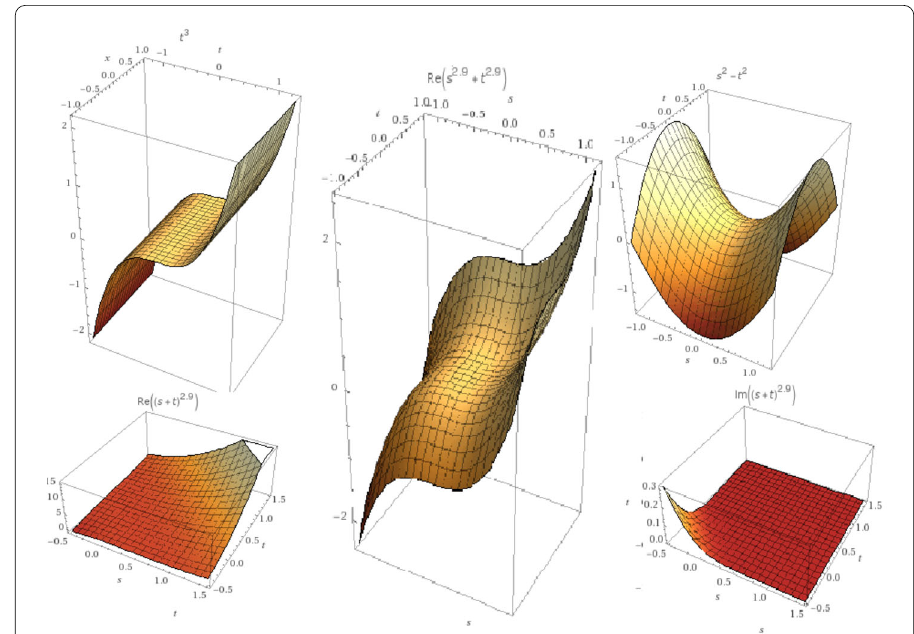
Figure 4 GB for the nonlinear case. From the left: the graph represents τ 3 , τς , and ς 2 – τ 2 respectively. The second row represents their fractional case when μ =